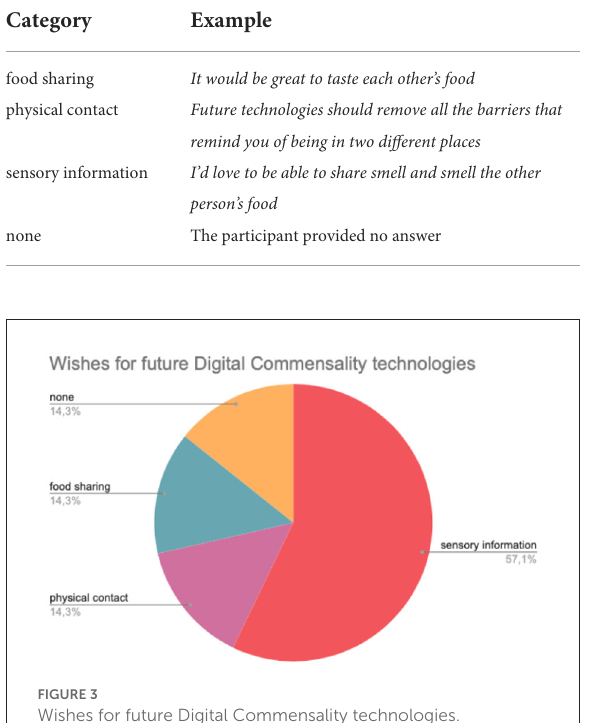
TABLE 6 Wishes for future Digital Commensality technologies.